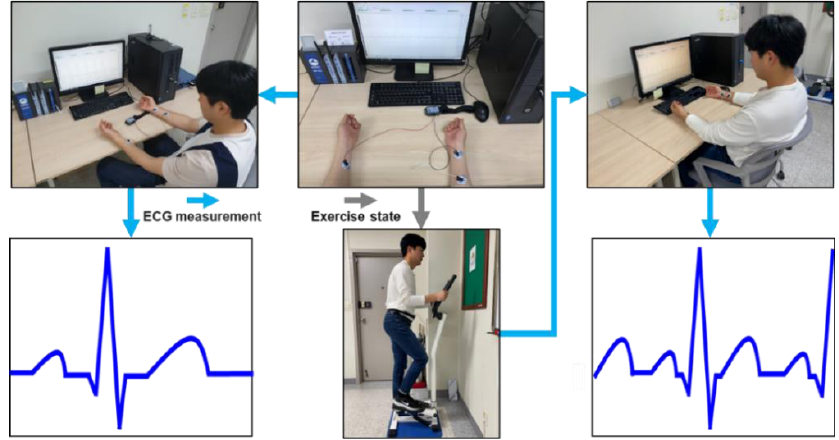
Figure 8. Conditions for pre- and post-exercise ECG measurement and the morphological features of the measured ECG one cycle. The cycles before and after exercise and compare the user recognition performances before and after normalization.